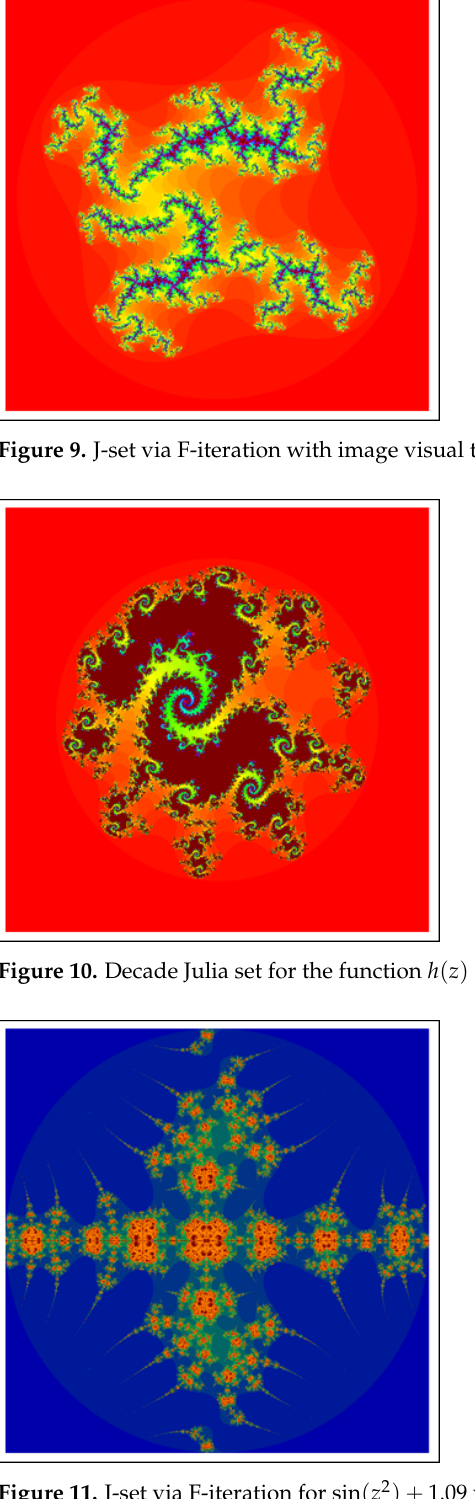
Figure 11. J-set via F-iteration for sin ( z 2 ) + 1.09 with visualization period = 119.03